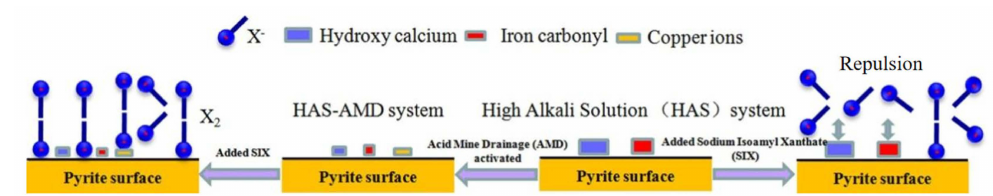
Figure 4. Adsorption model diagram of the HAS-depressed pyrite flotation with AMD